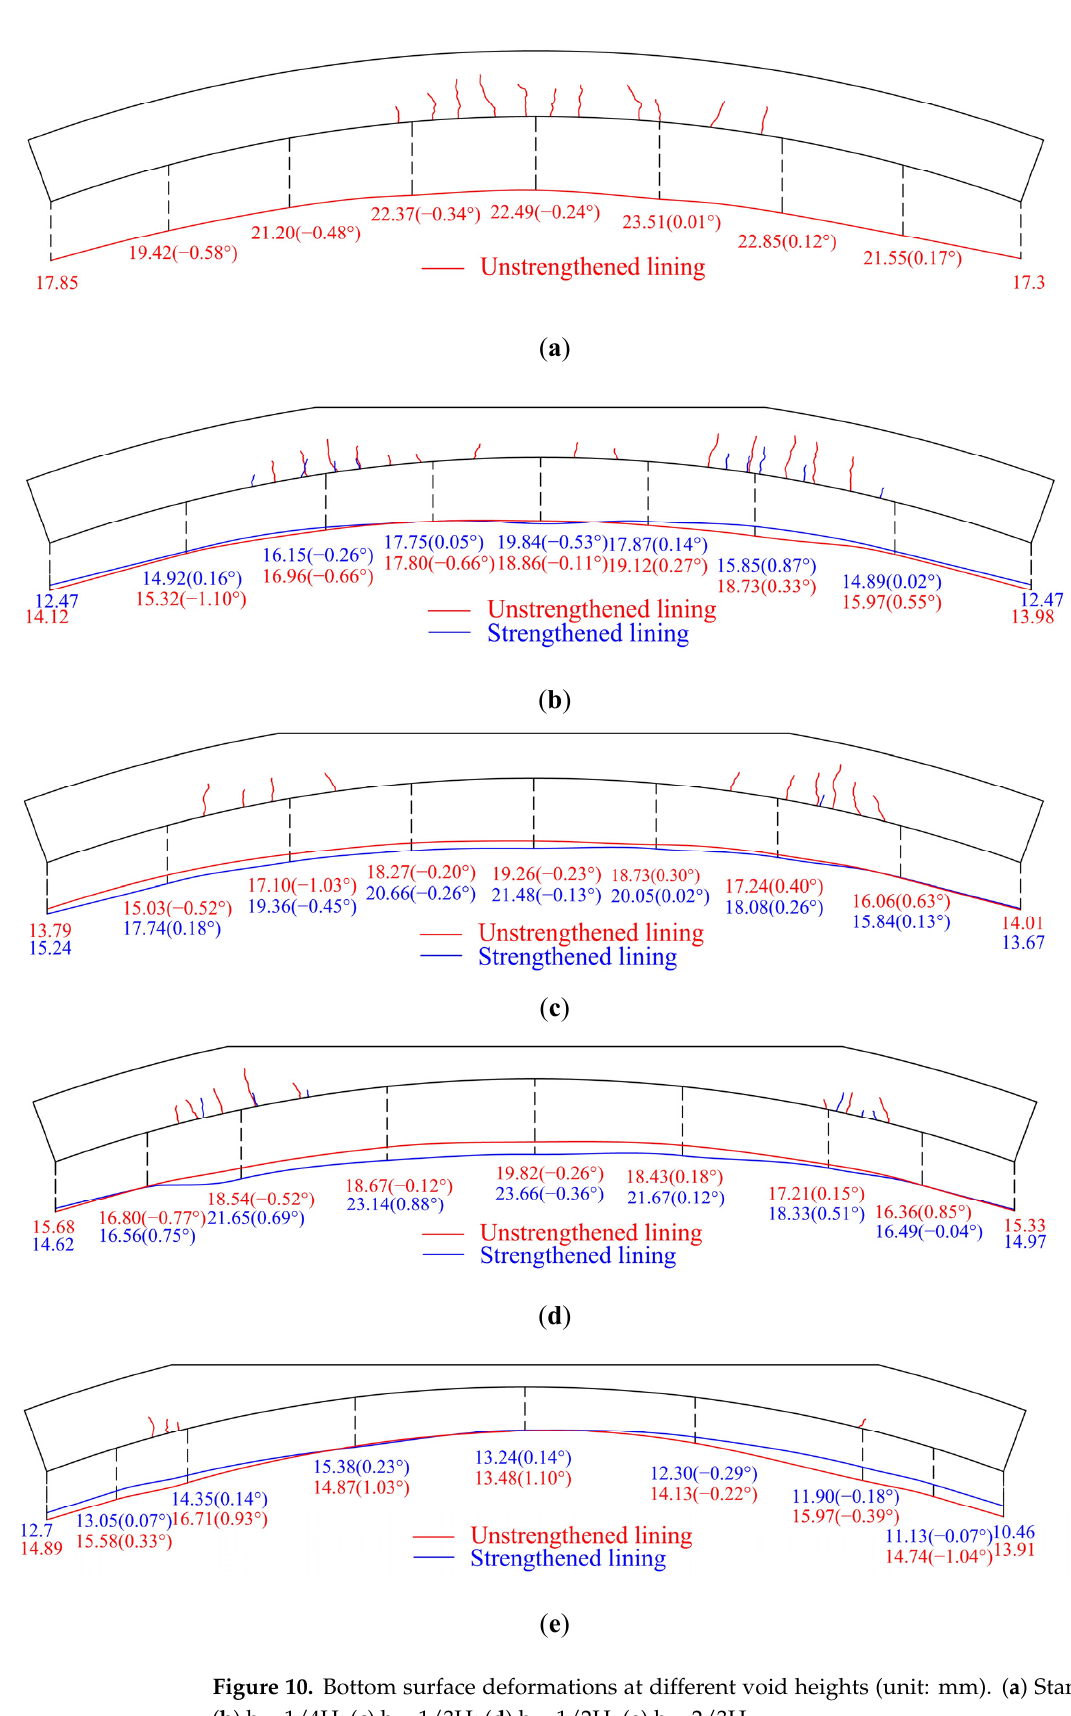
Figure 10. Bottom surface deformations at different void heights (unit: mm). ( a ) Standard